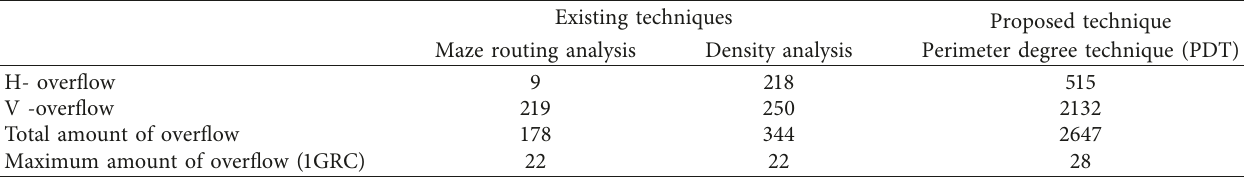
Table 1: Parametric Comparison of the Proposed and existing methods in the field.